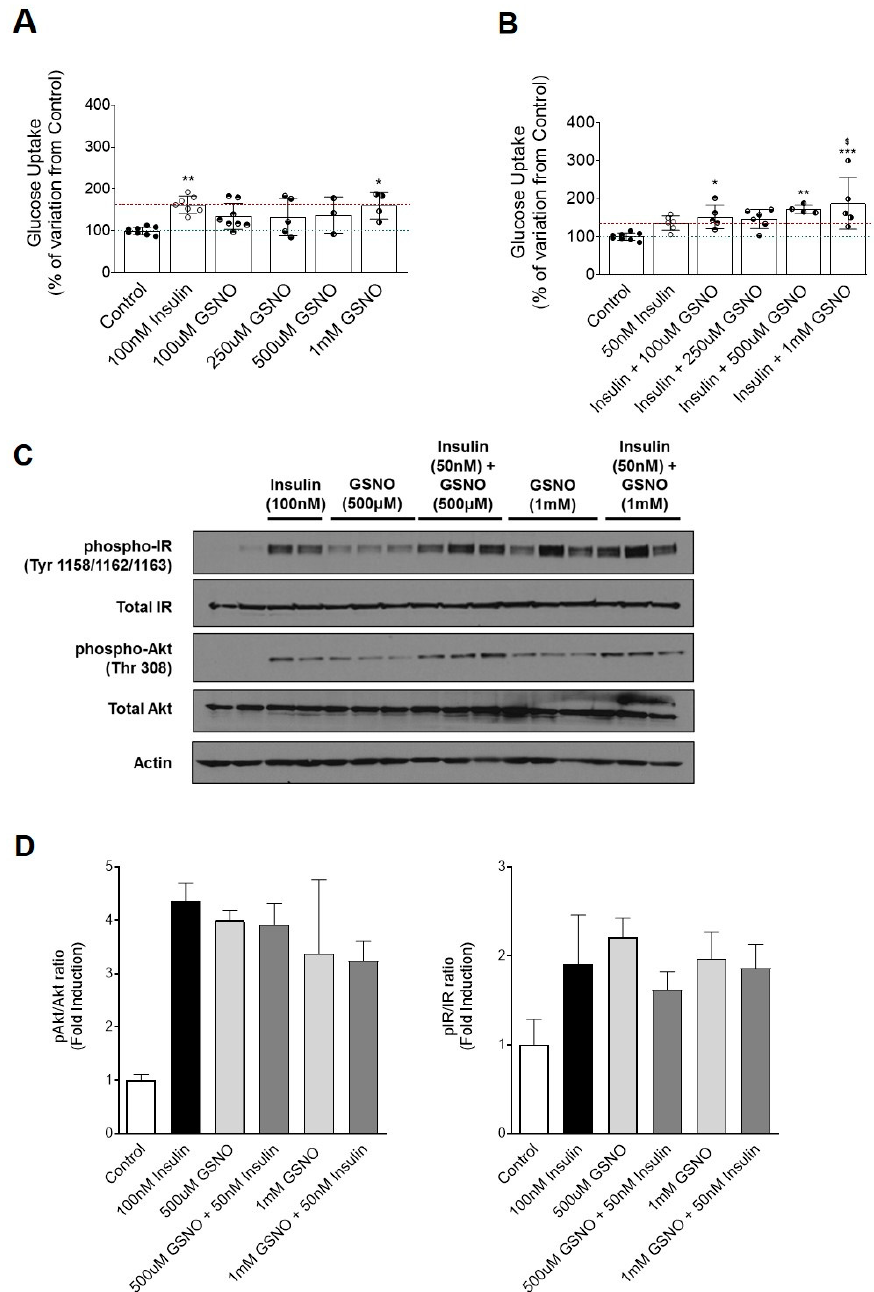
Figure 4. S-nitrosglutathione (GSNO) administration promotes glucose uptake in L6 myotubes and positively modulates the insulin signaling pathway. ( A ) Glucose uptake in L6 myotubes after incubation with insulin (100 nM) or different dosages of GSNO (100–1000 μ M); ( B ) glucose uptake in L6 myotubes after incubation with insulin (50 nM) concomitantly with GSNO (100–1000 μ M); ( C ) representative images of the phospho- and total insulin receptor (IR) and the phospho- and total Akt (Protein Kinase B) and actin protein levels in L6 myotubes, after stimulation with insulin and / or GSNO; and ( D ) relative quantification of phospho-IR / IR and phosphor-AKT / AKT ratios. Data are presented as mean ± SEM for 3–8 replicates per group. * p < 0.05; ** p < 0.01, *** p < 0.001 vs. control group by a one-way ANOVA; $ p < 0.05 vs. 50 nM insulin group by a one-way